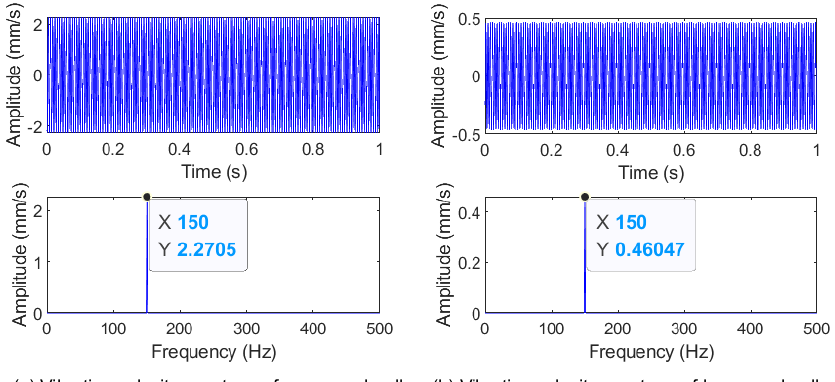
Figure 8. Rolling mill vibration spectrum at C = 1, f = 150 Hz.